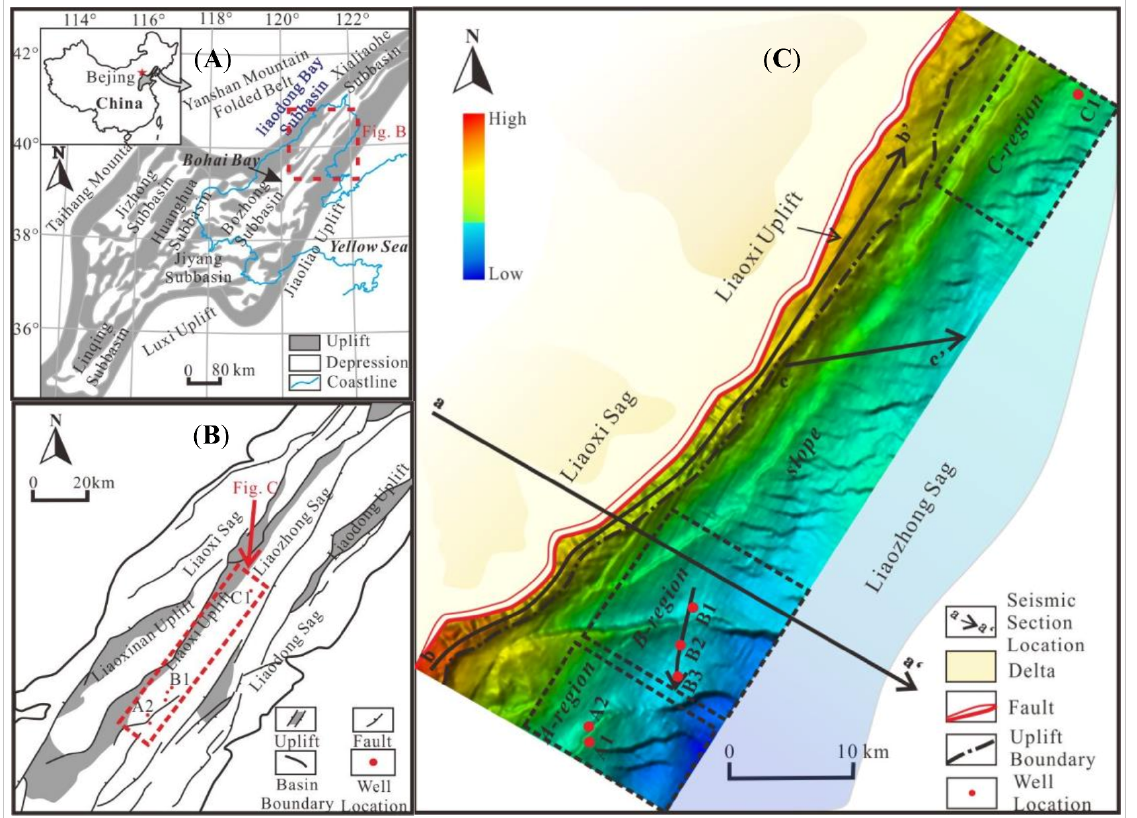
Figure 1. ( A ) Tectonic division and location of Bohai Bay Basin (modified from Jia et al., 2021 [39]). ( B ) Regional tectonic units of Liaodong Bay Depression. ( C ) Residual landform of Liaoxi uplift and slope. The study area covers the Liaoxi Uplift and the eastern gentle slope belt (Figure